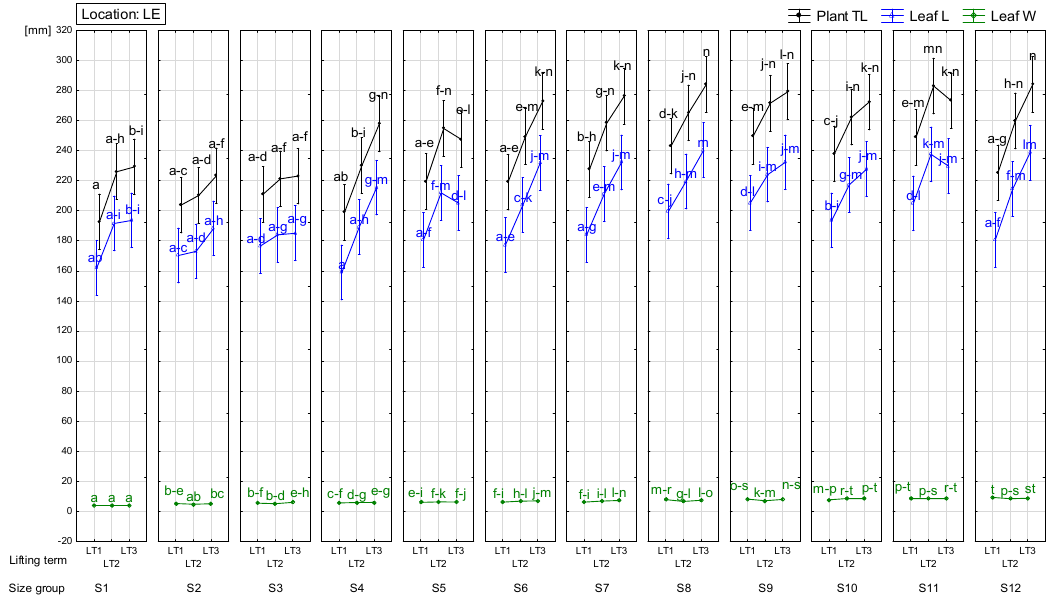
Figure 6. Effect of size group and lifting term on morphological features of bulbs and leaf for Lednice (LE) location. Mean values within the same color with different letter are significantly different according to Duncan’s multiple range test at p ≤ 0.05. For treatments description, see 2.1.–2.4, Materials and Methods sections.